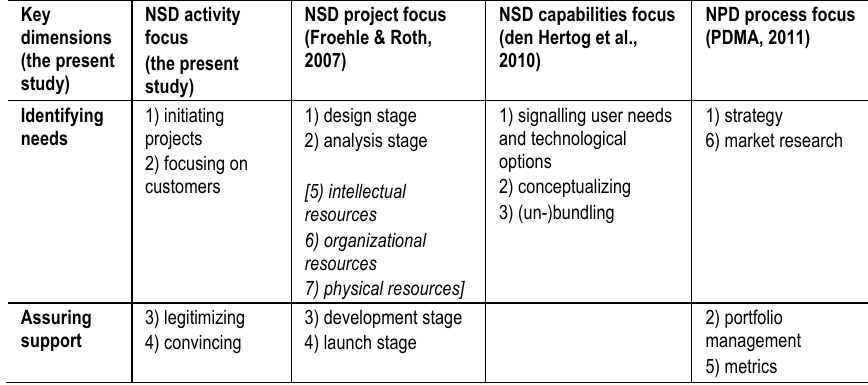
Table 4. Key dimensions of new service development